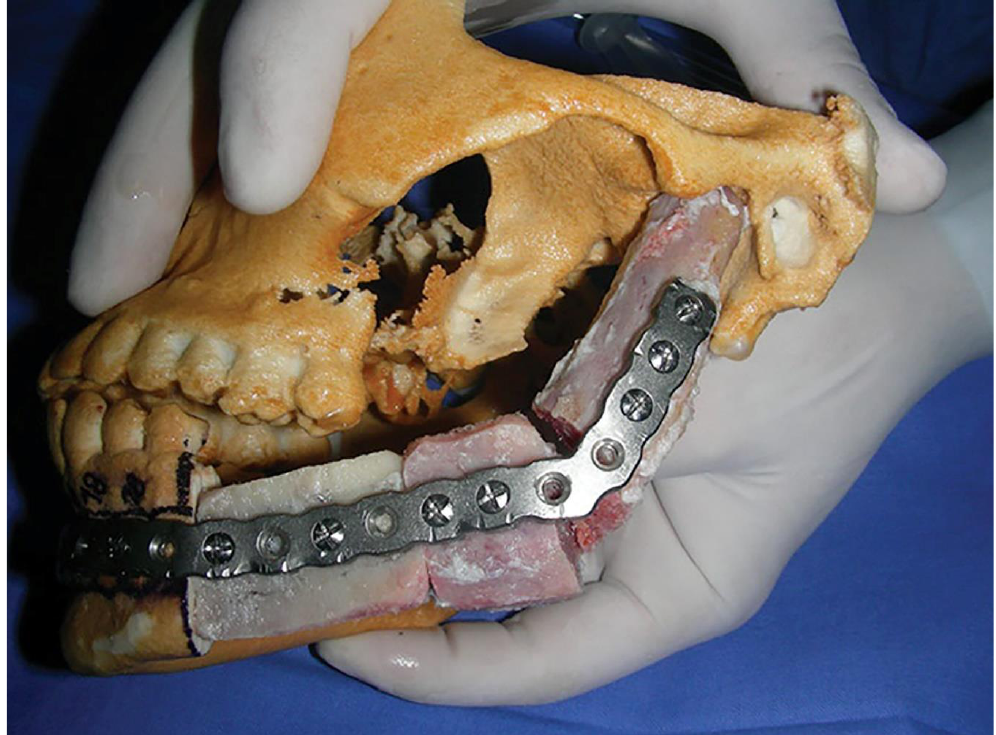
Figure 4. Non-vascularised iliac bone graft adapted to premolded reconstructing plate. Reprinted with permission from [45] .